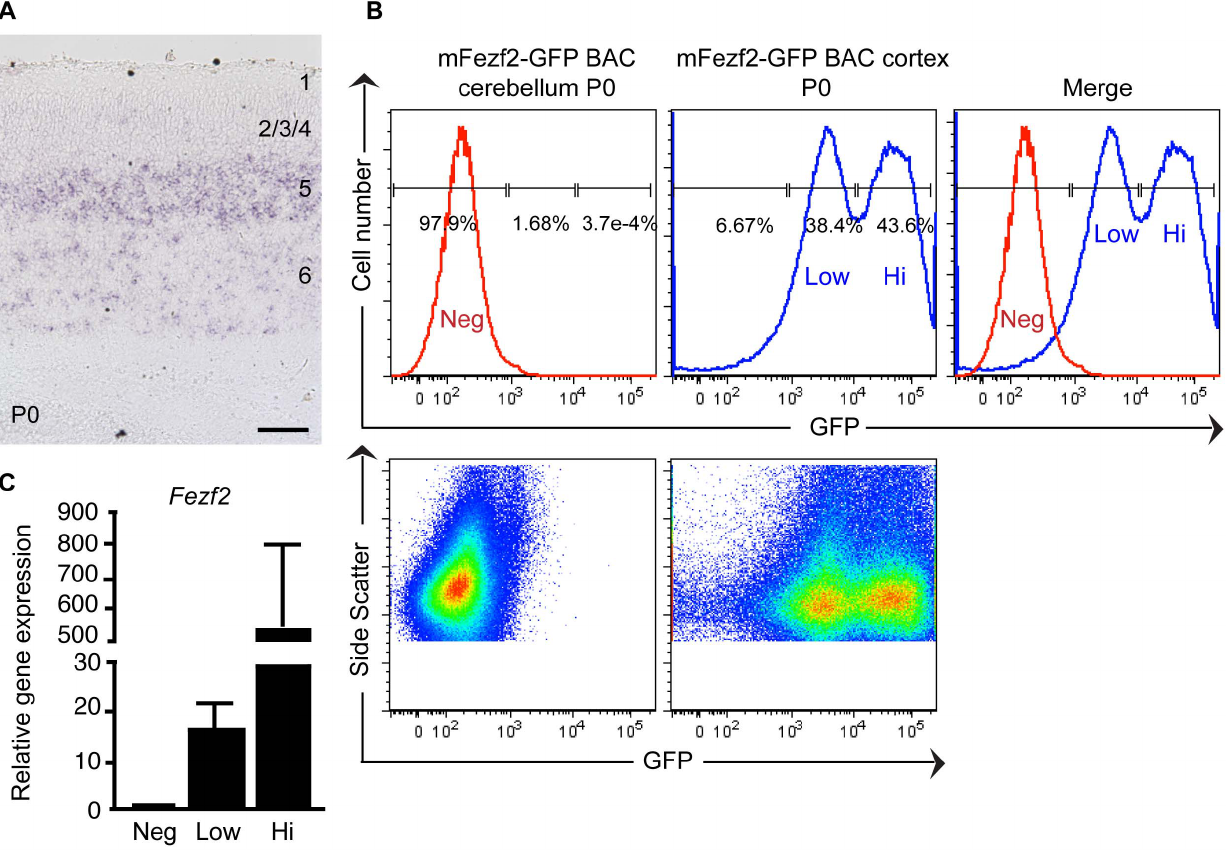
Figure 5. Fezf2 -GFP BAC transgenic mice contain two distinct Fezf2 -GFP + populations. ( A ) In situ hybridization shows that a P0 wild-type mouse cortex contains layer 5 neurons expressing Fezf2 at a high level and layer 6 neurons expressing Fezf2 at a low level. ( B ) Representative FACS histograms and dot plots of P0 Fezf2 -GFP BAC transgenic mice show that the cerebellum contains a m Fezf2 -GFP Neg population, and the cerebral cortex contains m Fezf2 -GFP Hi and m Fezf2 -GFP Low populations. ( C ) Quantitative RT-PCR analysis of m Fezf2 mRNA expression levels in sorted m Fezf2 - GFP Hi , m Fezf2 -GFP Low and mFezf2-GFP Neg sub-populations.